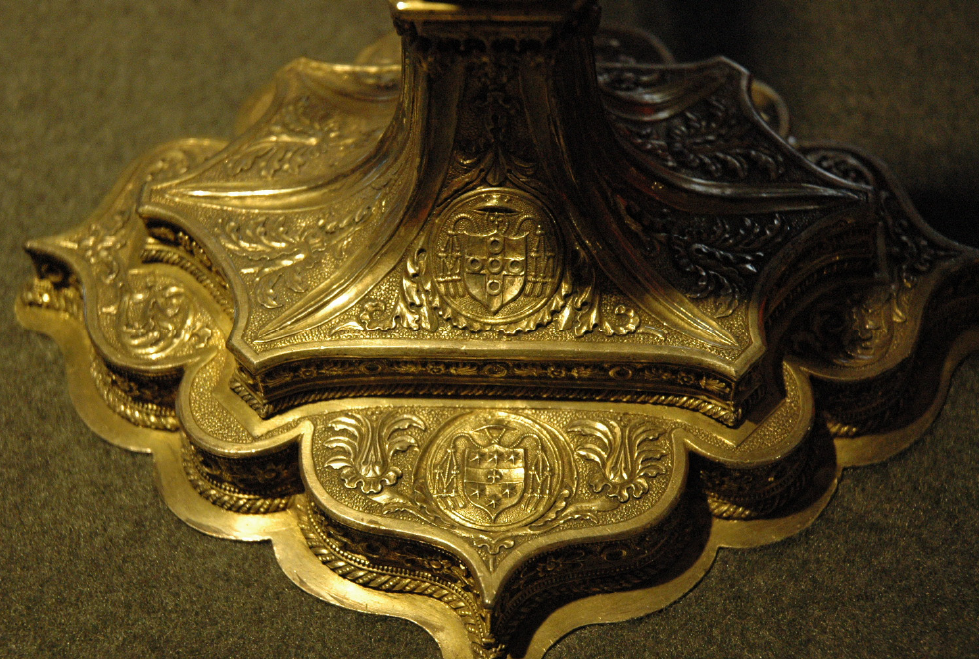
Figure 2. Detail from Figure 1. Cardinal Piccolomini’s and Casini’s coat of arms on the front of the Ostensory (photo: author).